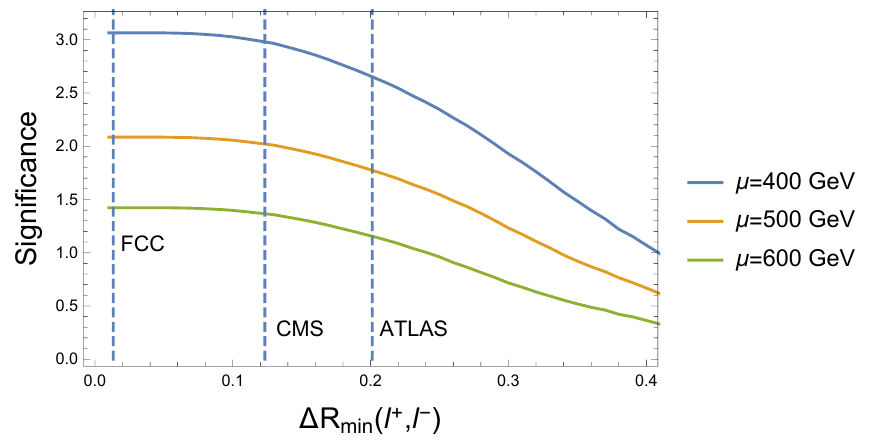
Figure 9 . Signi(cid:12)cances as a function of the minimum resolvable distance between leptons, (cid:1) R min ( l + ; l (cid:0) ) for a nominal (cid:1) + = 344 MeV. We have superimposed the (cid:1) R min ( l + ; l (cid:0) ) values corresponding to the Delphes parameterizations of ATLAS, CMS and the FCC